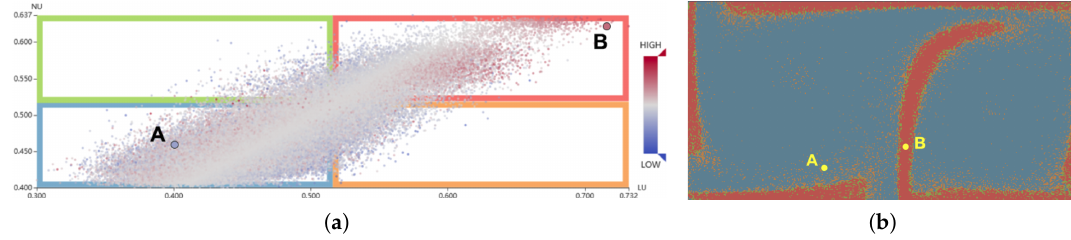
Figure 4. Classification view: ( a ) four regions of the classification space and mapped grid points and ( b ) a rendering of the original vector field with the colors used in ( a